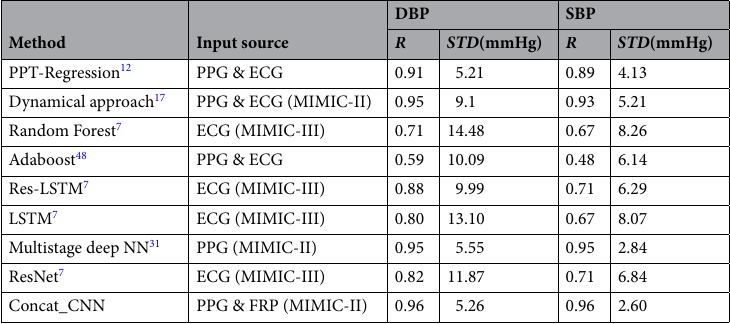
Table 4. Comparison with the previous studies.